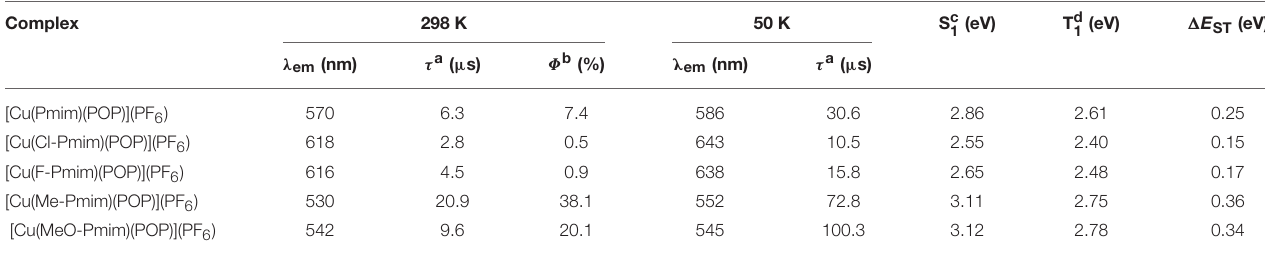
TABLE 2 | Emission data of the Cu(I)-NHC complexes in solid state at 298 and 50K. Complex 298